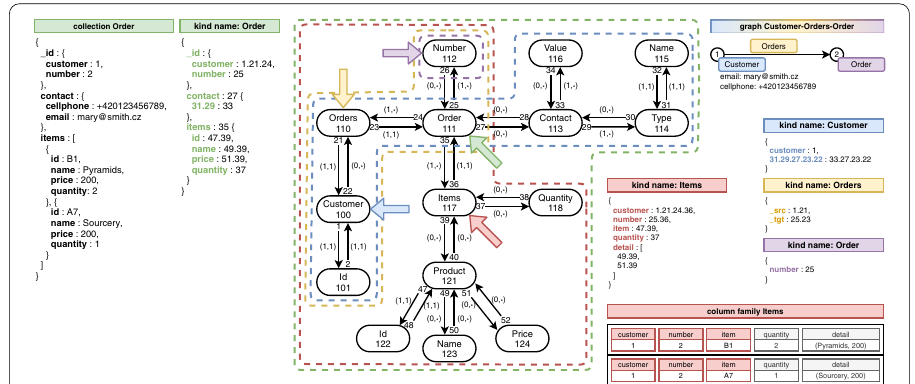
Fig. 12 Example of transformation from document model to graph and column